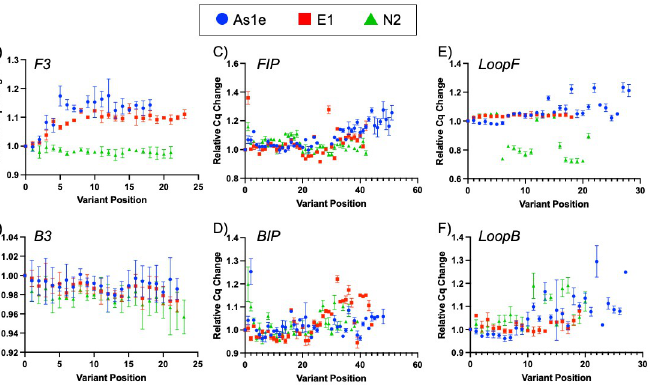
Fig 1. Mutation position effects on RT-LAMP amplification. Plots of the effects on amplification speed relative to the WT primer set for all 3 assays explored, As1e (blue circle), E1 (red square), N2 (green triangle). (A) F3 primer, (B) B3 primer, (C) FIP primer, (D) BIP primer, (E) Loop F primer, (F) Loop B